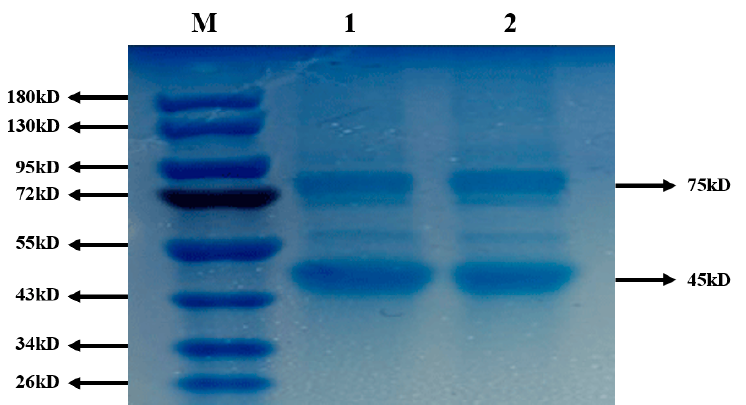
Figure 7. Detection of integrity of NDV in SiO 2 @CMCS- N -2-HACC by Western blotting: ( M ) protein marker; ( 1 ) inactivated NDV; ( 2 ) recovery in NDV/SiO 2 @CMCS- N -2-HACC.